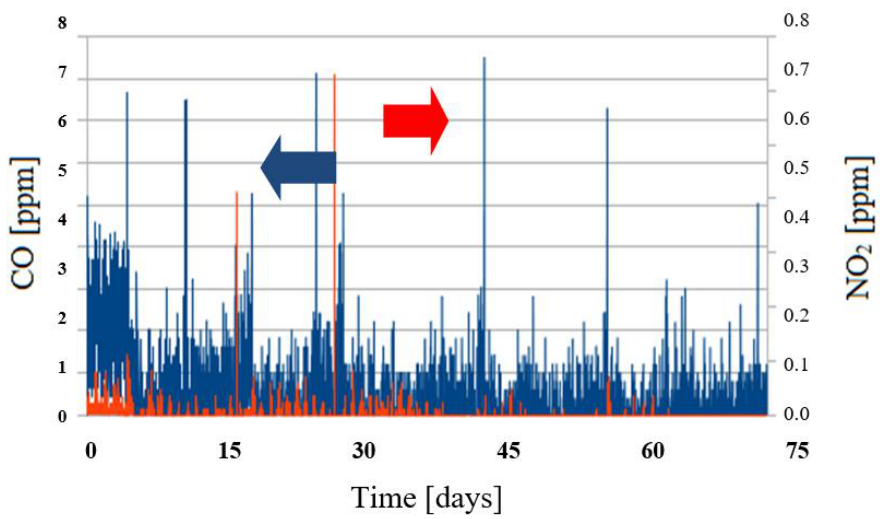
Figure 7. Measurement campaign (3 months) in Doha (Qatar) dedicated to CO and NO 2 evaluation.